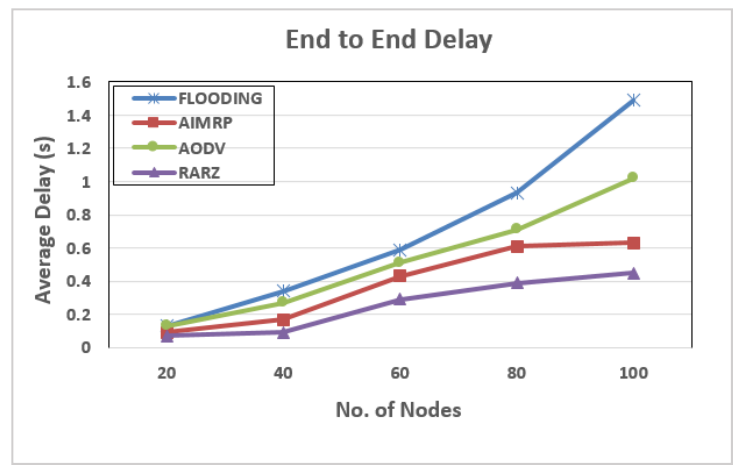
Figure 9. End-to-end delay as a function of the number of nodes.